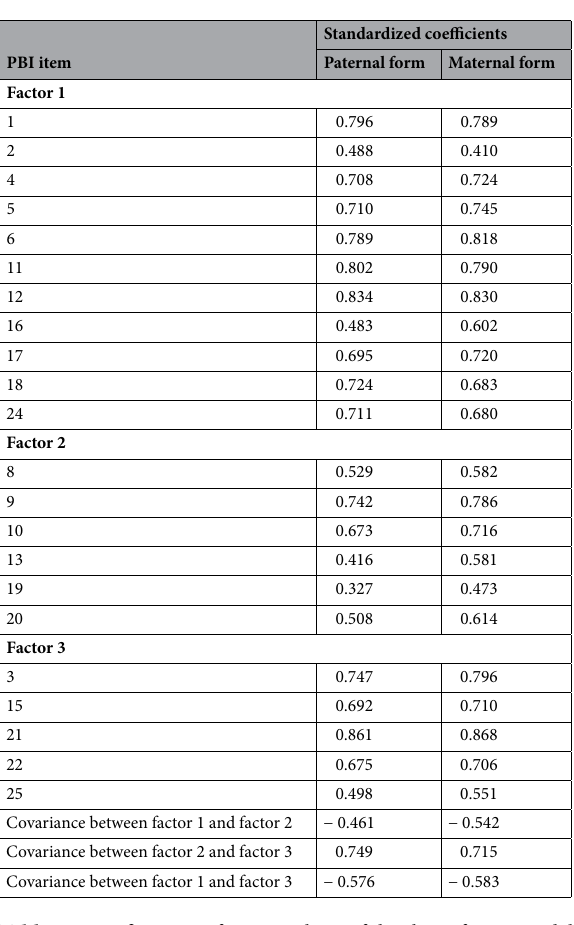
Table 2. Confirmatory factor analysis of the three-factor model (n = 2330).